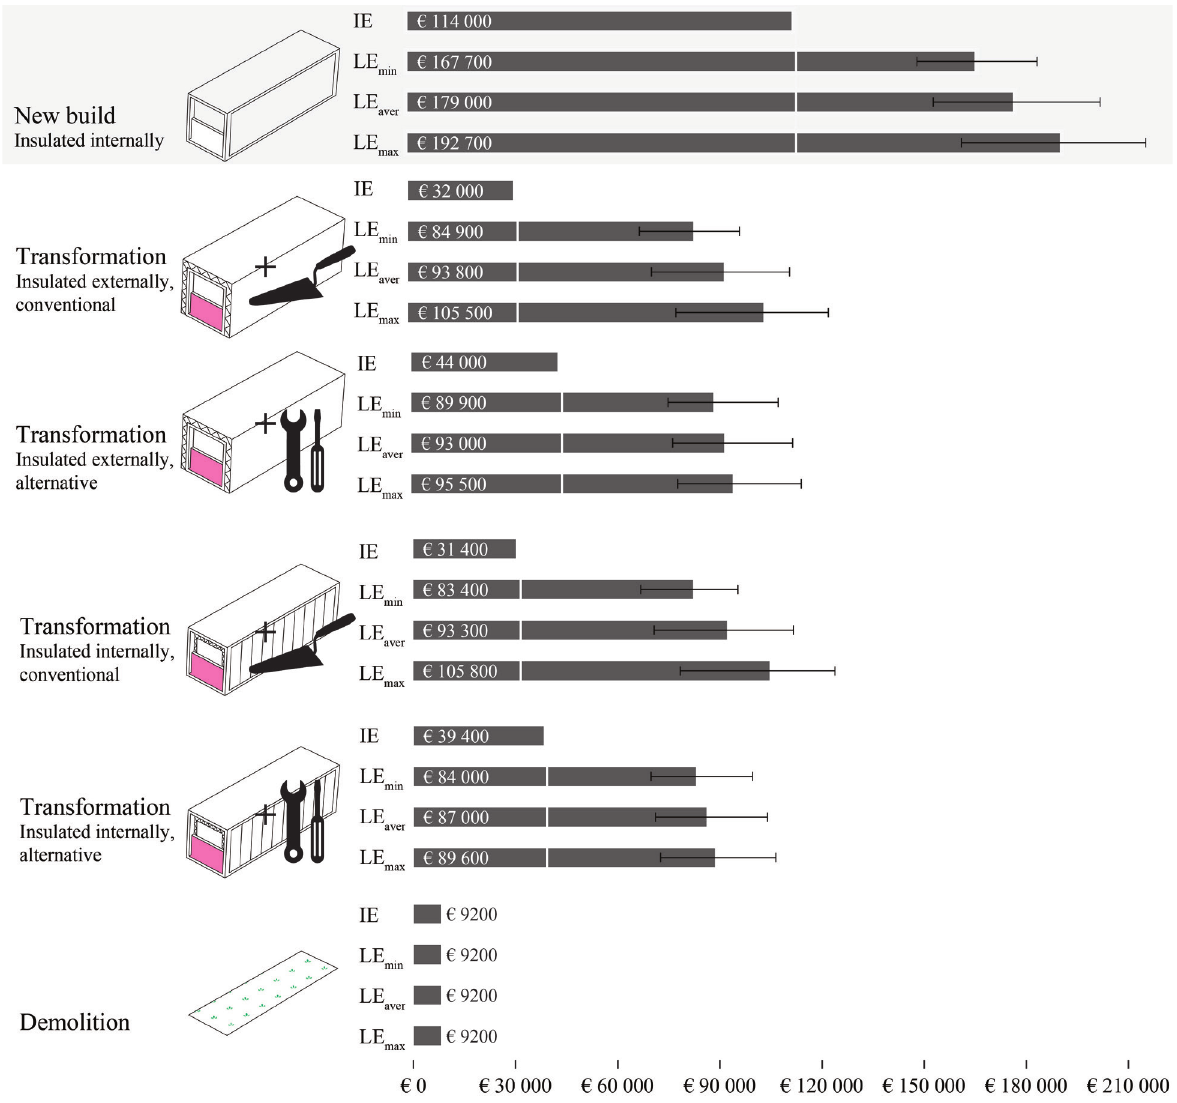
Figure 8. The outcomes of the life cycle assessments for the cluster of modules (with a floor area of 433 m 2 ) show that a transformation can have a lower impact compared to new construction and that a demountable detailing for all elements is only useful if the refurbishment frequency is average or higher. With IE as initial environmental impact, LE min as life cycle impact with no refurbishments, LE aver as life cycle impact with an average number of refurbishments, LE max as life cycle impact with a maximum number of refurbishments during 60 years, the error bars represent the results of the sensitivity analysis on a variable lifespan of the building (from 30 to 79